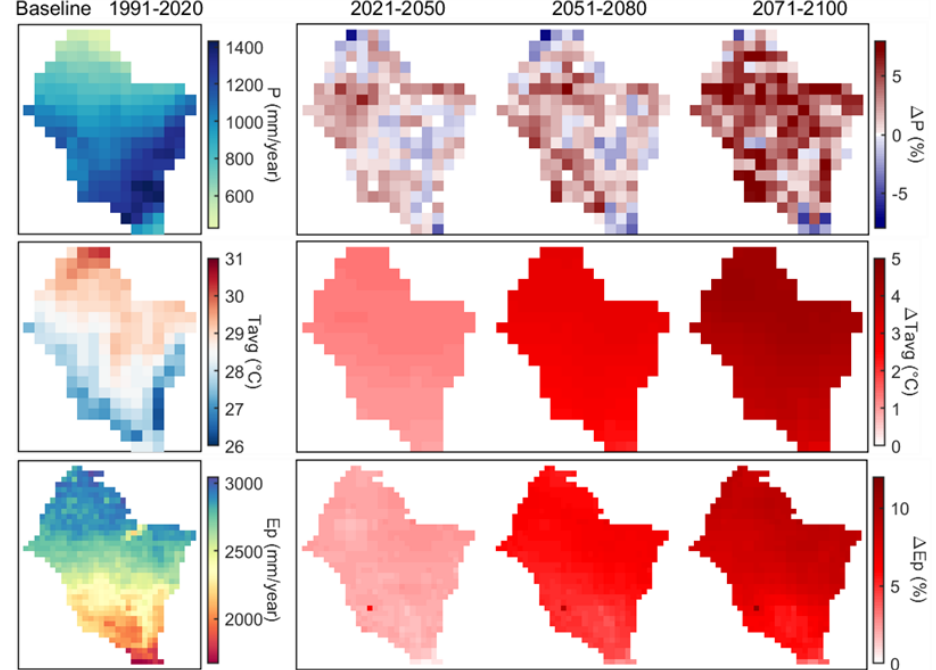
Figure 10. Spatial patterns of the long-term average of annual climatic variables over the historical period (1991–2020) and changes over future periods (2021–2100) under RCP8.5 (median of 18